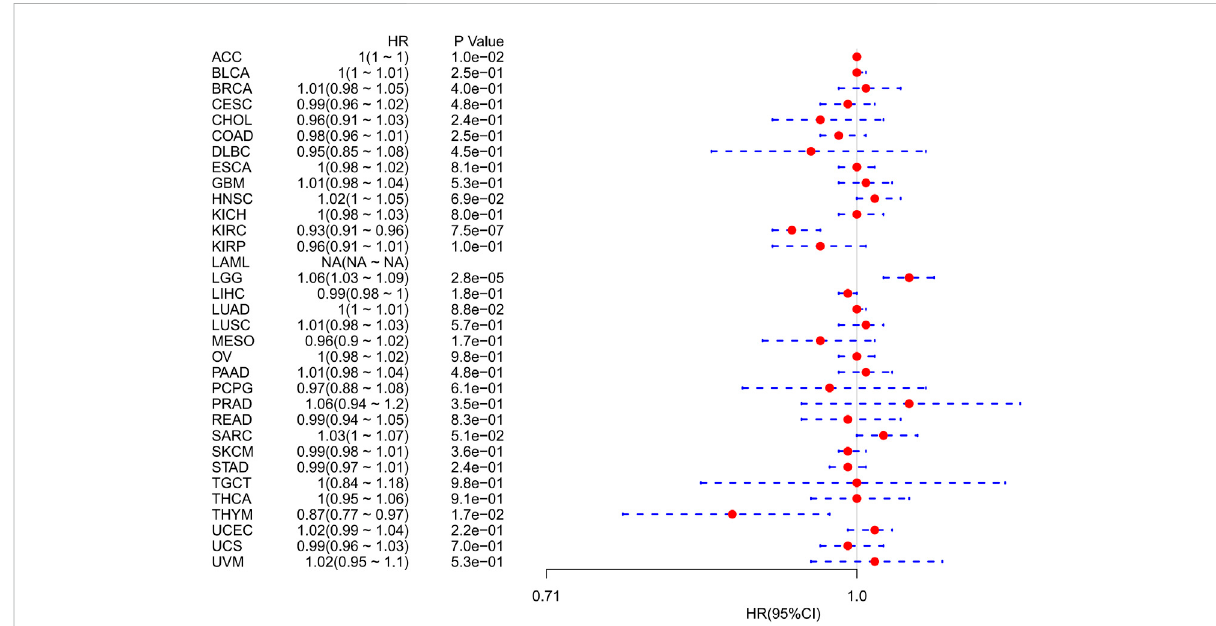
FIGURE 4 Correlation between FDX1 mRNA expression levels and disease-speci fi c survival in multiple tumors from the Cancer Genome Atlas database. Cox regression analysis, p < 0.05 was